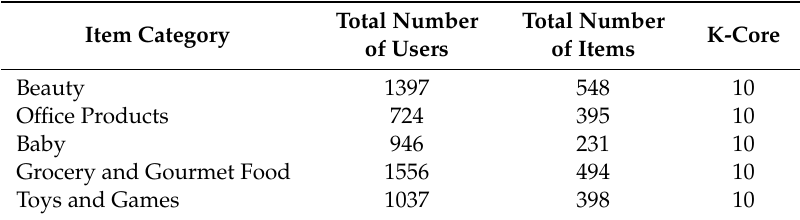
Table 3. Experimental dataset